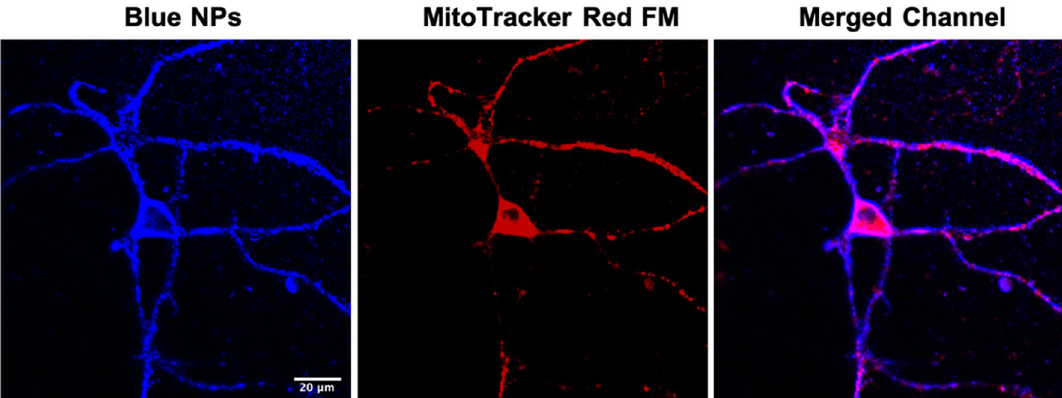
Figure 3. Neuronal imaging under confocal microscopy. The images showed labelling from blue NPs (left) and MitoTracker Red (middle) and merged channel from blue and red (right). The excitation wavelength is 405 and 595